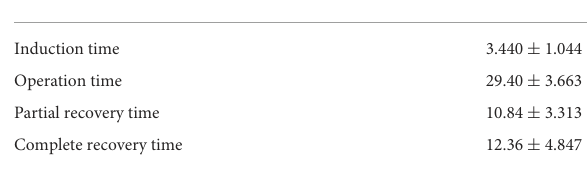
TABLE 2 Measurements of the anesthetic protocol